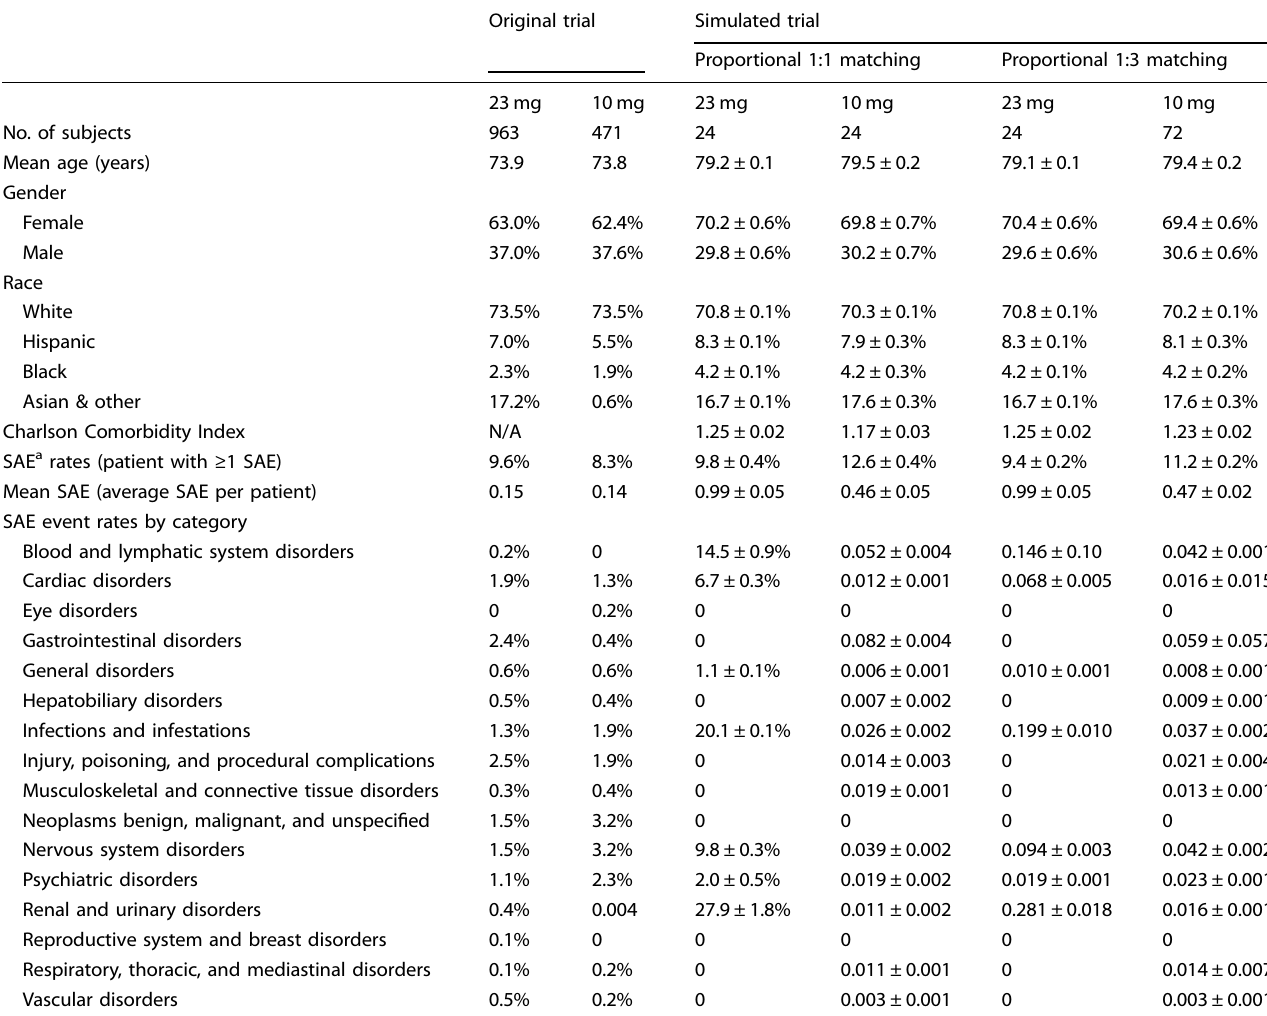
Table 3. Results of the two-arm simulation for proportional 1:1 and 1:3